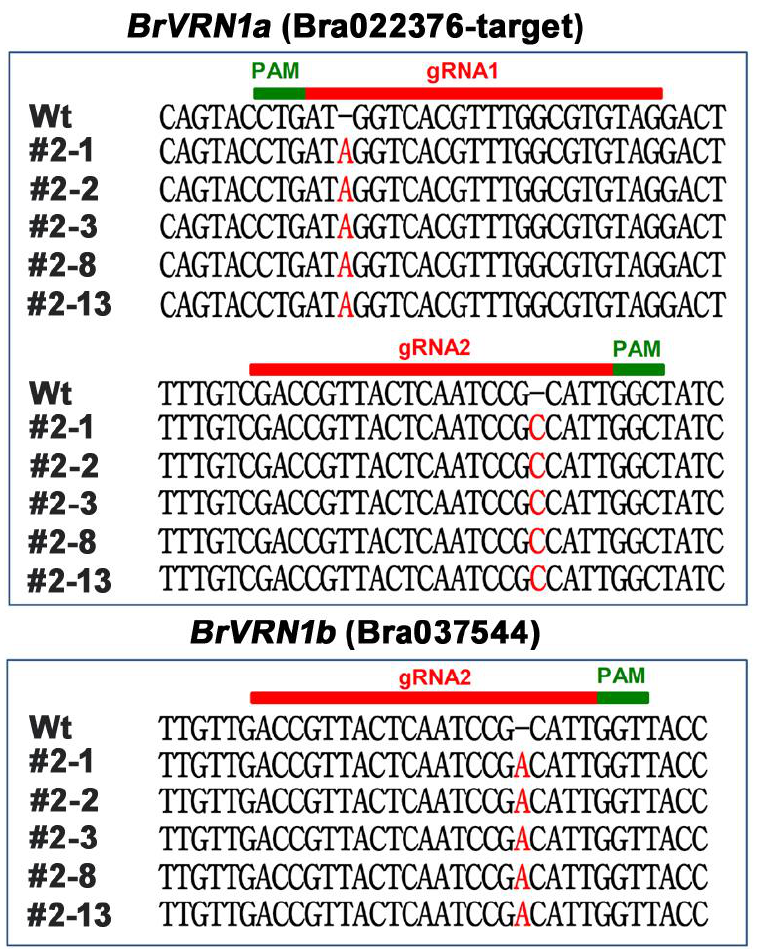
Figure 2. Target gene mutations by the multiplex CRISPR/Cas9 system in the T 1 generation. The mutated DNA sequences of target regions are provided. Gene mutations are in red. Wt, untransformed wild-type plants; lanes #2-2 to -8, selected GE1 lines, respectively.